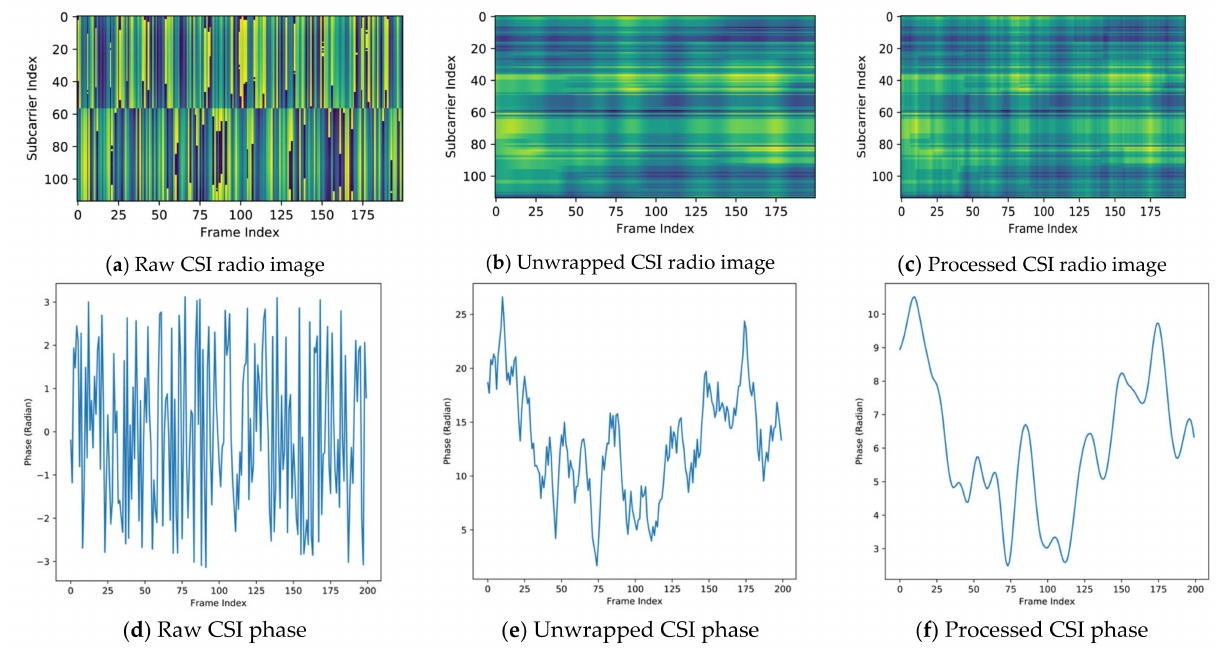
Figure 4. Comparison of the CSI phase before and after processing. The upper row shows CSI radio images, and the lower row shows the waveform of the CSI